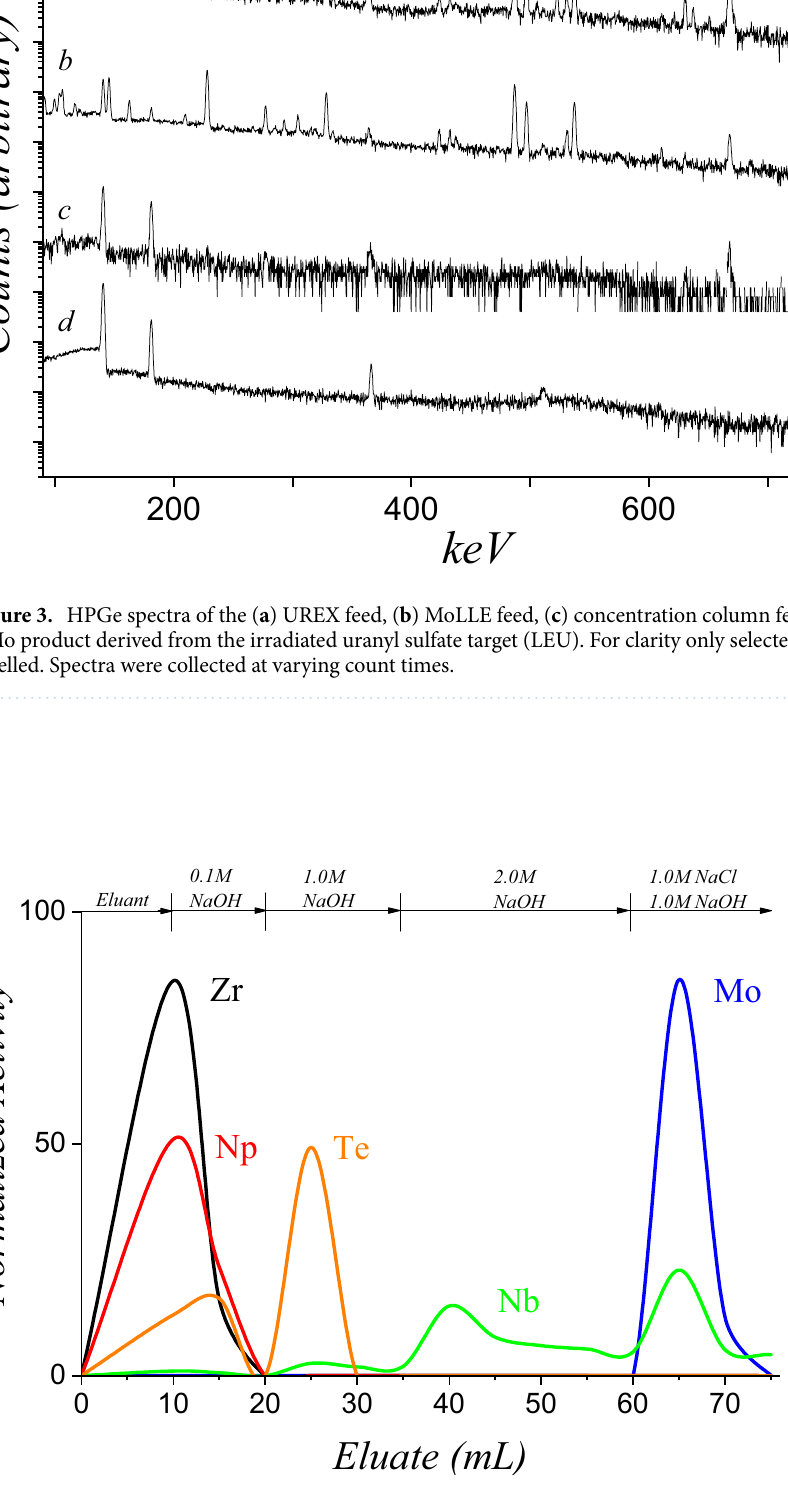
Figure 4. Elution profile of Zr, Np, Te, Nb, and Mo on an anion exchange resin. The feed solution was derived from the irradiated natural